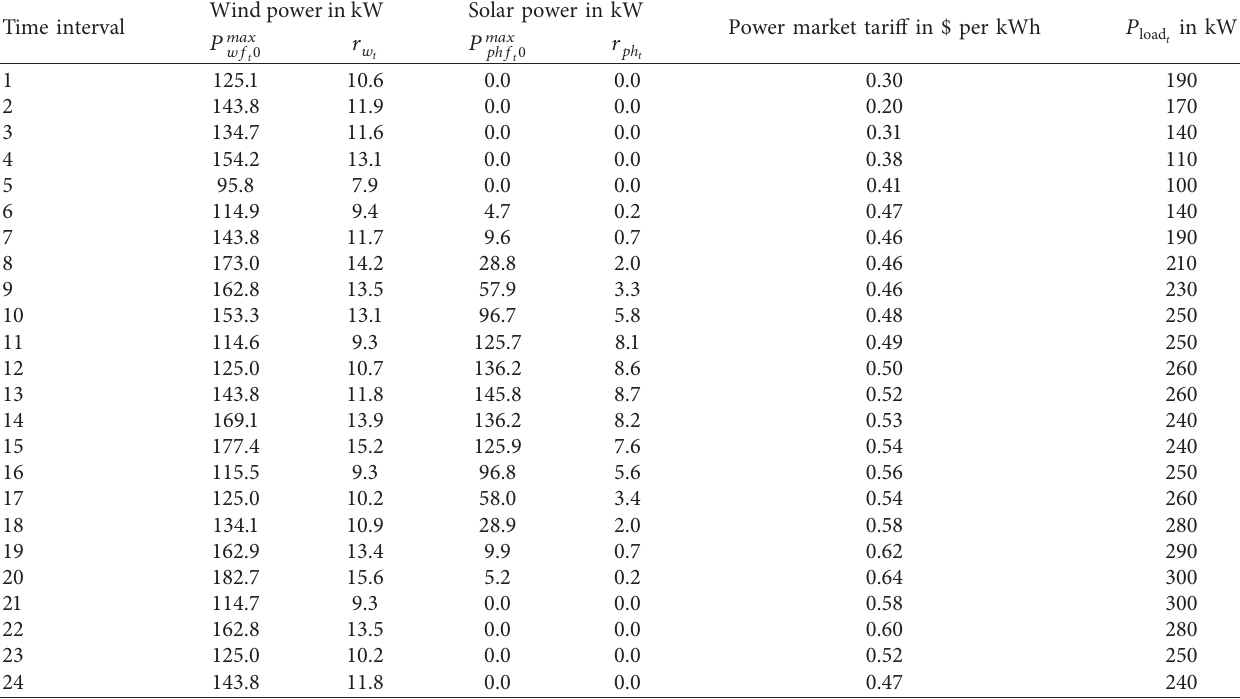
Table 2: Used data for the supplied power by green power sources, demands, and power market tariffs (hourly data). Time interval